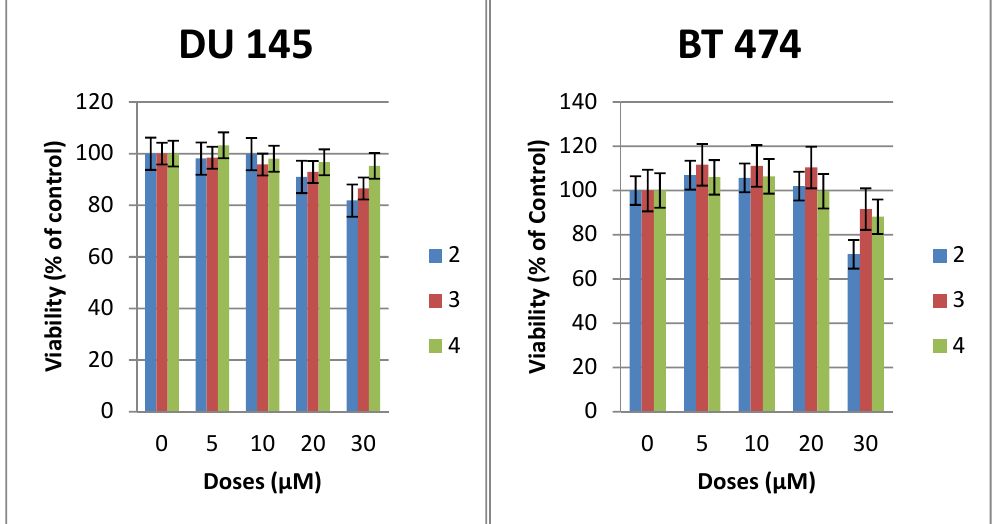
Figure 2. Effects of compounds 2 – 4 on the viability of epithelial cancer cell lines: breast (BT474, JIMT1), prostrate (DU 145), pancreas (MiaPaCa2). The results represent the means ± standard deviations of six independent determinations (compound 1 is not included in this chart because we have previously published the data